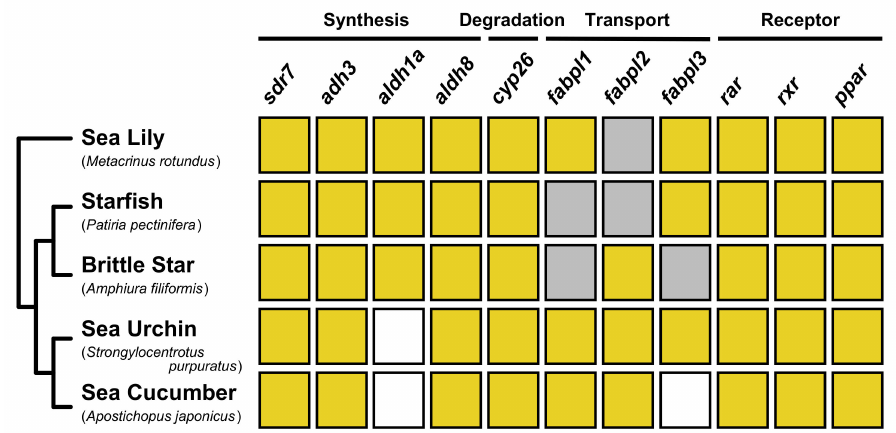
Figure 8. Summary of gene identification of RA signaling components in echinoderms. Yellow boxes indicate the presence of ortholog genes. On the other hand, gray and white boxes indicate the absence of ortholog genes in the search of transcriptomic and genomic dataset,